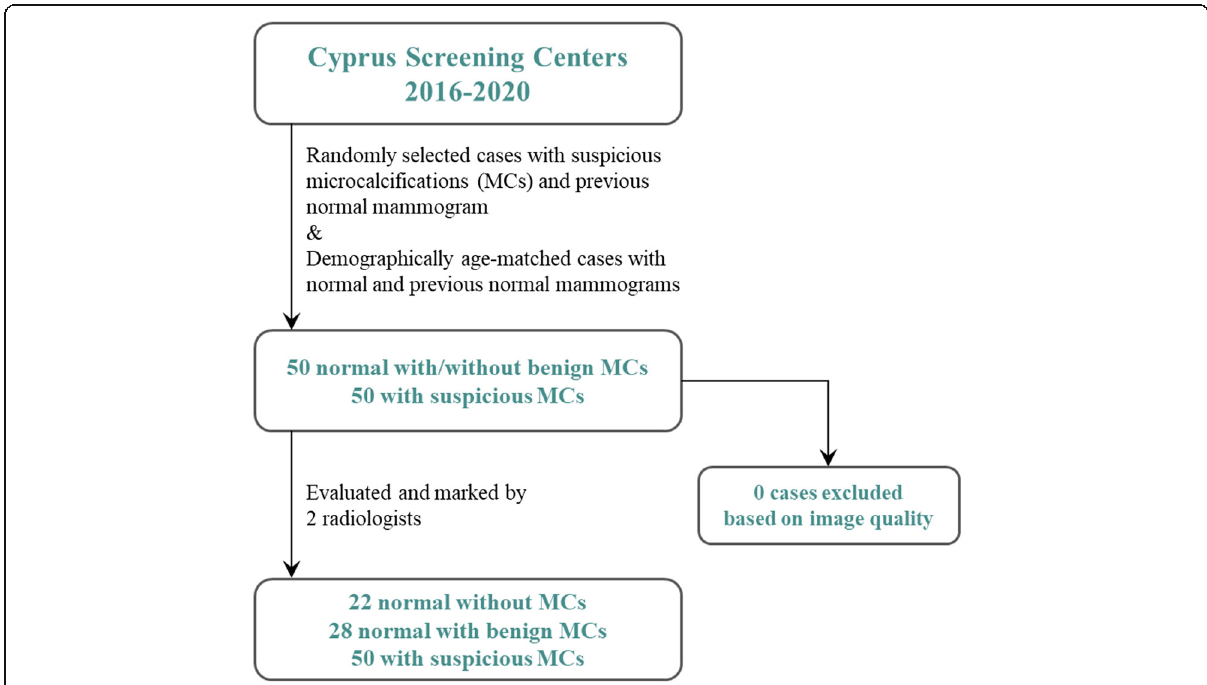
Fig. 1 Flowchart of study population selection. MCs Microcalcifications